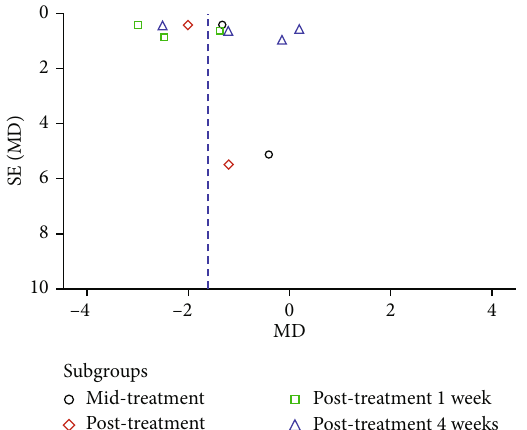
Figure 3: Funnel plot regarding self-reported neuropathic pain in the rTMS group compared with the control